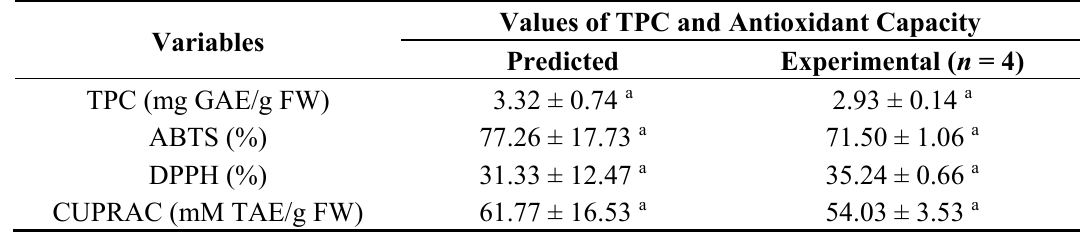
Table 4. Validation of the predicted values for total phenolic content (TPC) and antioxidant capacity.